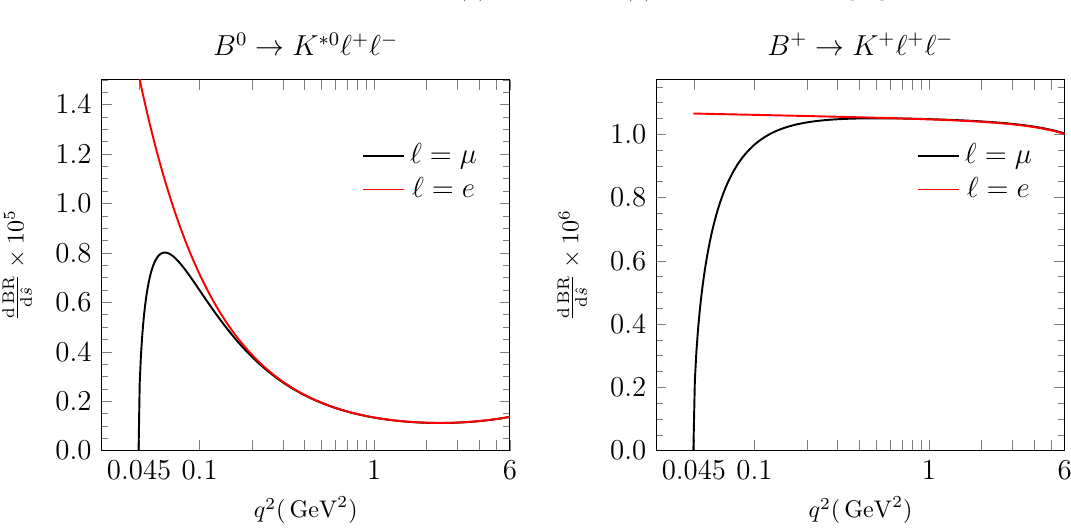
in the SM at the leading order, as d ^ s